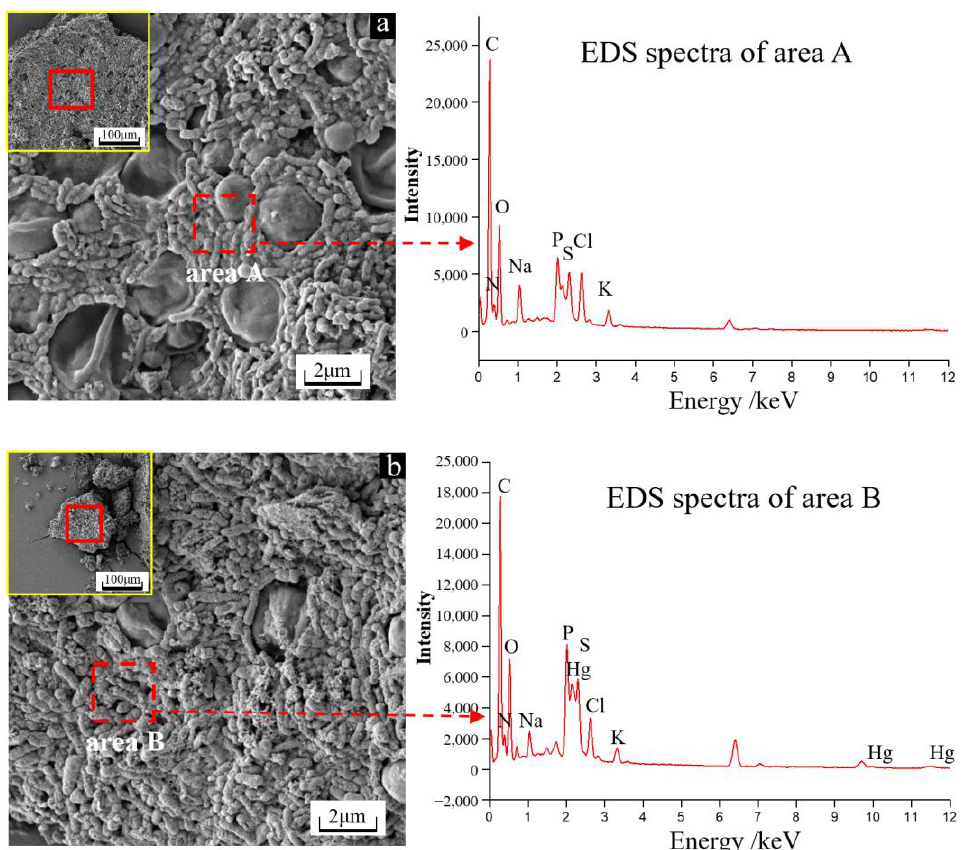
Figure 2. SEM images and EDS spectra of the microbial cells on day 48 for the groups without ( a ) and with ( b ) Hg 2+ .